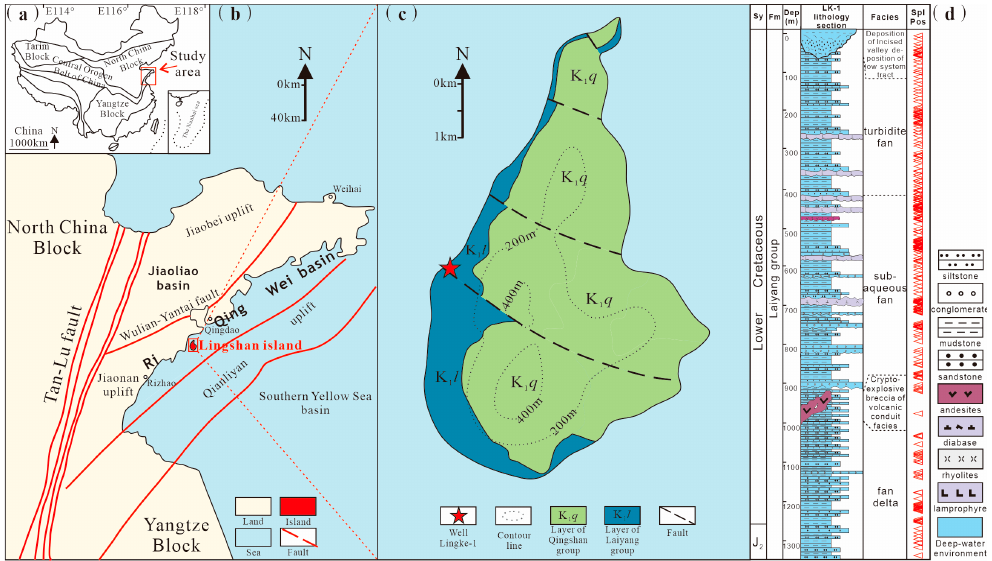
Figure 1. Tectonic map of the Riqingwei Basin and lithological section of the well LK-1: ( a ) simpli fi ed map of China showing major blocks and its boundaries (modi fi ed from [24]); ( b ) geological map of the Riqingwei basin (modi fi ed from [25]); ( c ) geological map of the Lingshan Island, location of well LK–1(modi fi ed from [22]); and ( d ) composite stratigraphic column and sampling locations of the Laiyang Formation in well LK-1(modi fi ed from [22]).